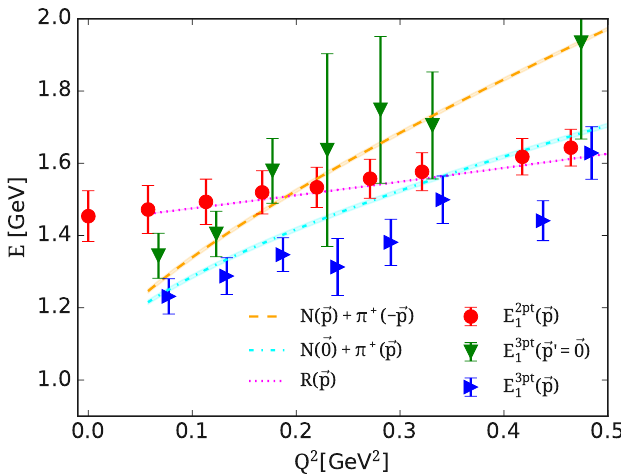
Figure 2: The energy of the first excited state as a function of Q 2 . The orange dashed and cyan dashed-dotted lines are the energies of the non-interacting systems (cid:126) N ( (cid:126) p )+ π ( − (cid:126) p ) and N ( 0 )+ π ( (cid:126) p ) , respectively, and the magenta dotted line is the Roper energy. The red circles are extracted by a two-state fit to the two-point function. The ( (cid:126) p ) and E 3pt ( (cid:126) p (cid:48) = (cid:126) 0 ) extracted blue right- and green down-pointing triangles are E 3pt 1 1 from the three-point function of the temporal axial-vector current with a two-state fit. Figure is taken from Ref. [ 25 ] .